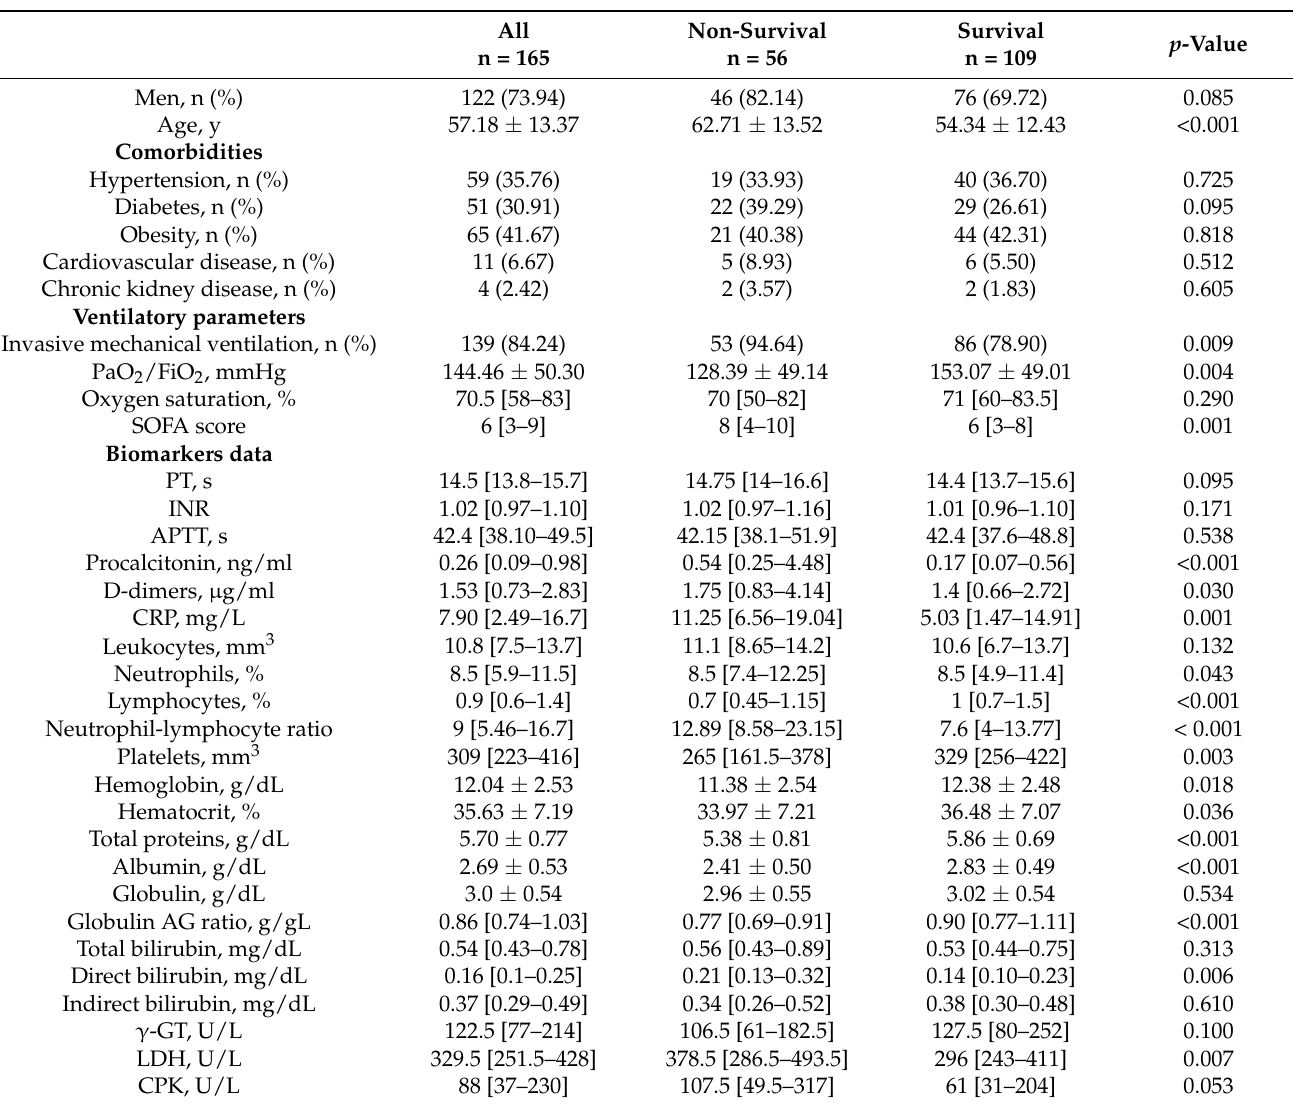
Table 1. Baseline